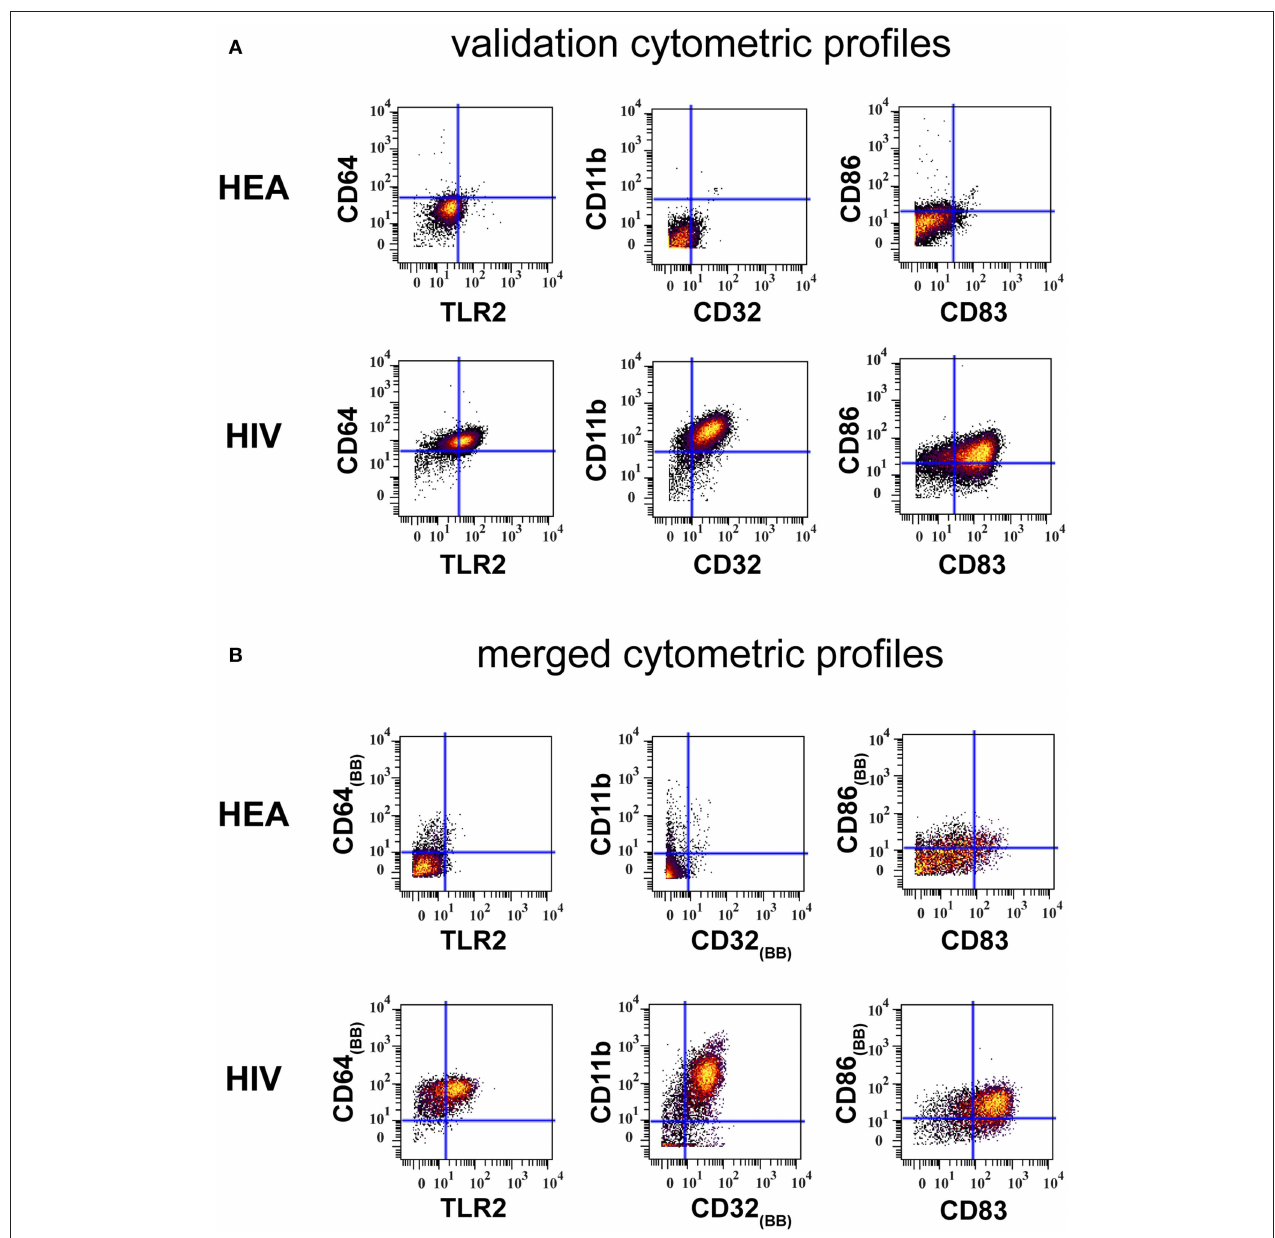
FIGURE 4 | Confirmation of results generated by CytoBackBone. (A) Leukocytes were collected from HIV-infected patients and healthy subjects. Cells were stained with a single antibody panel and SPADE analysis was performed to isolate monocytes. The biplot representations show the co-expression of CD64 and TLR2, CD11b and CD32, and CD86 and CD83 in monocytes from patient PAT-1. (B) Leukocytes were collected from HIV-infected patients and healthy subjects. Cells were stained with three different antibody panels. Then, CytoBacBone was used to merge the different cytometry profiles. SPADE analysis was then performed to isolate monocytes. The biplot representations show the co-expression of CD64 and TLR2, CD11b and CD32, and CD86 and CD83 in monocytes from patient